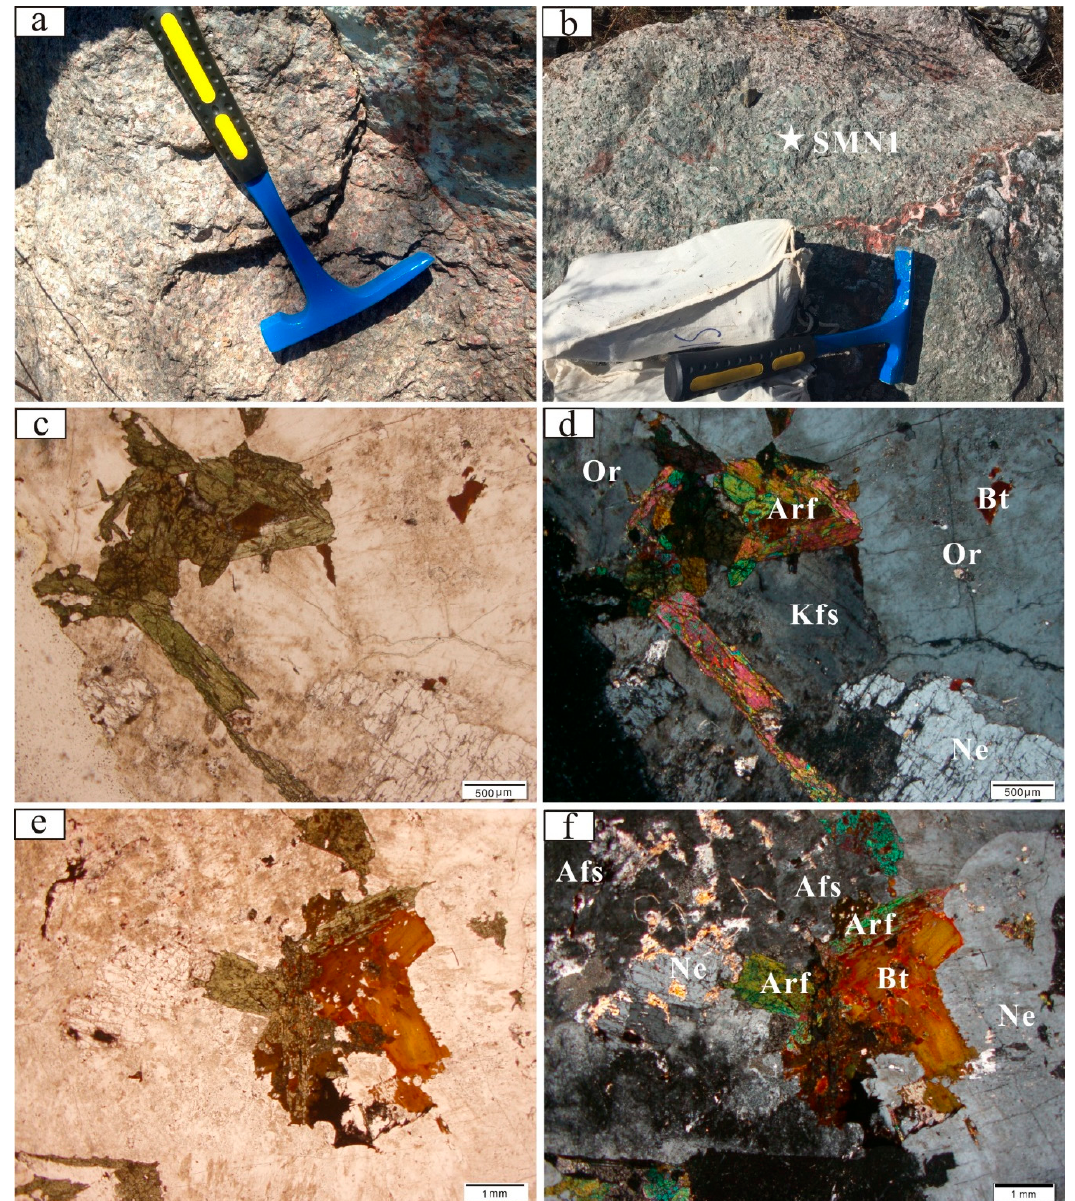
Figure 3. Representative outcrop-pictures and photomicrographs of the ore-forming rocks in Saima niobium deposit. ( a ) Brown aegirine nepheline syenite; ( b ) Grass-green aegirine–nepheline syenite(SMN1 is the sample number.); ( c ) Medium-coarse grained nepheline syenite (PPL); ( d ) Medium-coarse grained nepheline syenite (CPL); ( e ) Medium-coarse grained aegirine nepheline syenite (PPL); ( f ) Medium-coarse grained aegirine nepheline syenite (CPL). Mineral abbreviations: Afs, alkalifeldspar; Arf, arfvedsonite; Bt, biotite; Kfs, K-feldspar; Ne, nepheline; Or,